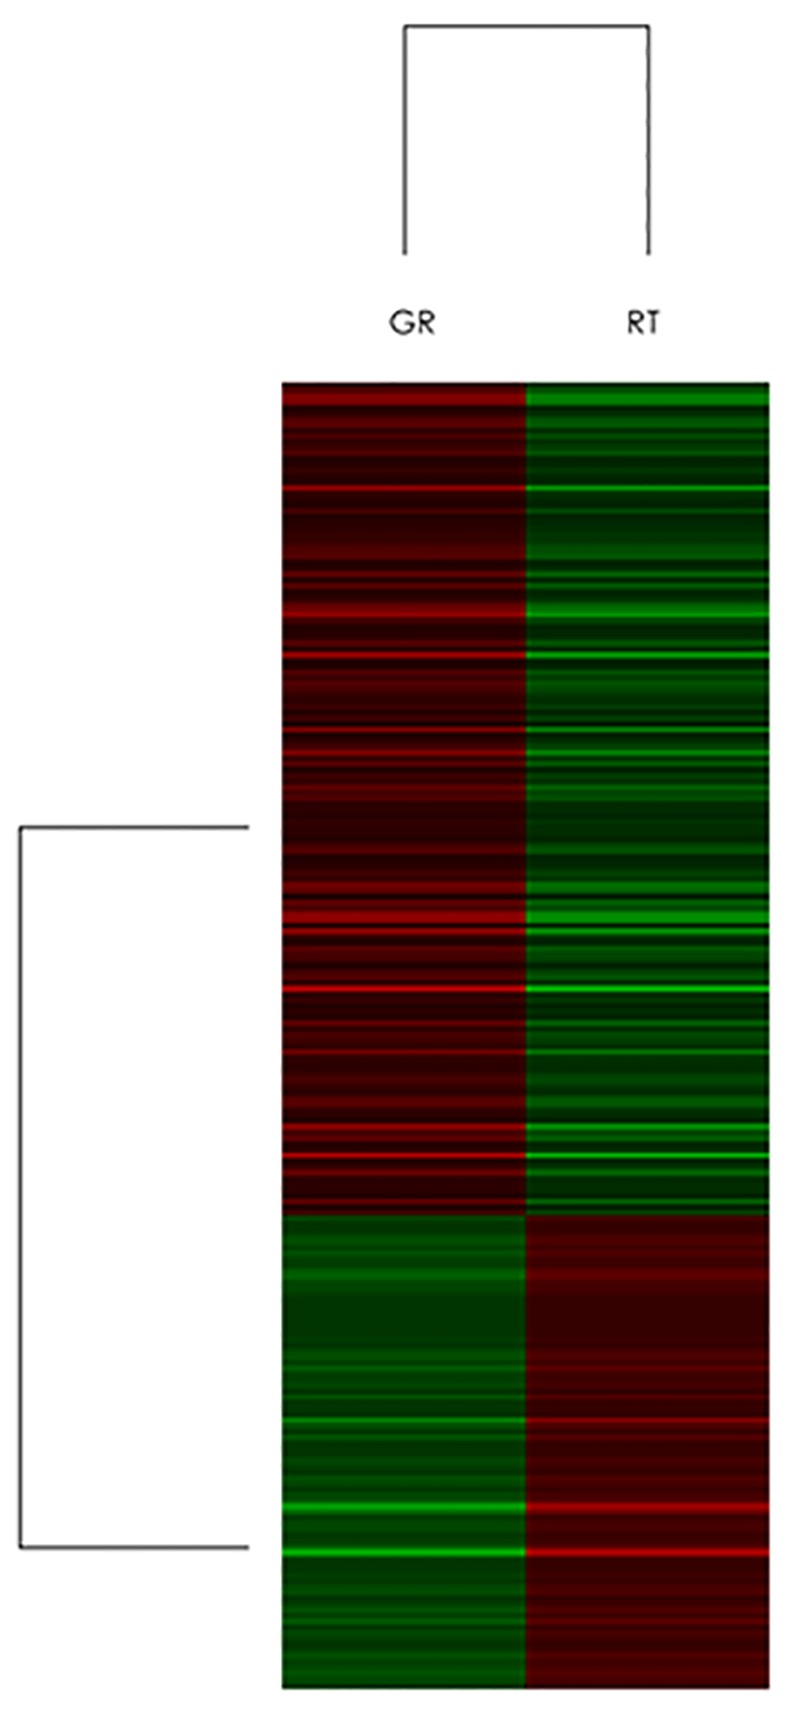
Clustering analysis of microarray.Clustering was performed to visualize the correlations between the replicates and varying sample conditions. Up- and down-regulated genes are represented in red and green colors, respectively. A subset of differential genes was selected for clustering analysis. An intensity filter was used to select genes where the difference between the maximum and minimum intensity values exceeds 1000 among all microarrays. For this microarray project, the number of genes clustered was 227.